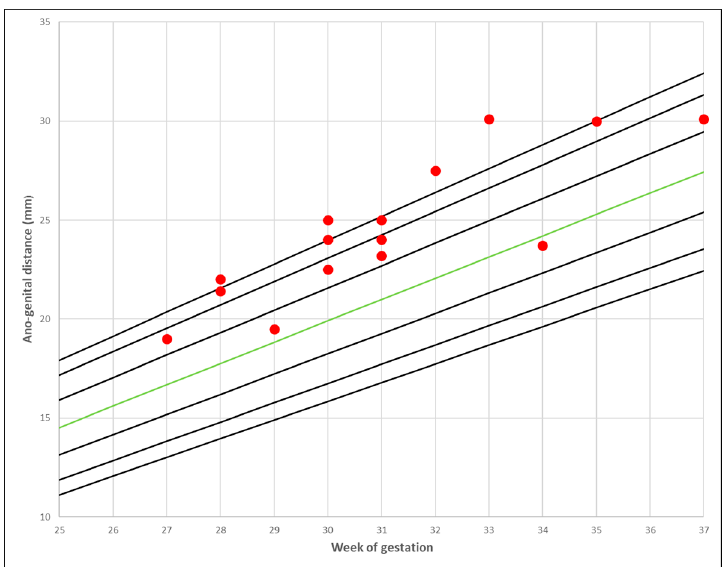
Figure 2. The ano-genital distance in PCOS mothers: male foetuses. The red marks represent the distribution of the measurements over the 2.5–97.5th centiles for local normal reference range. The green line represents the 50th centile [22].